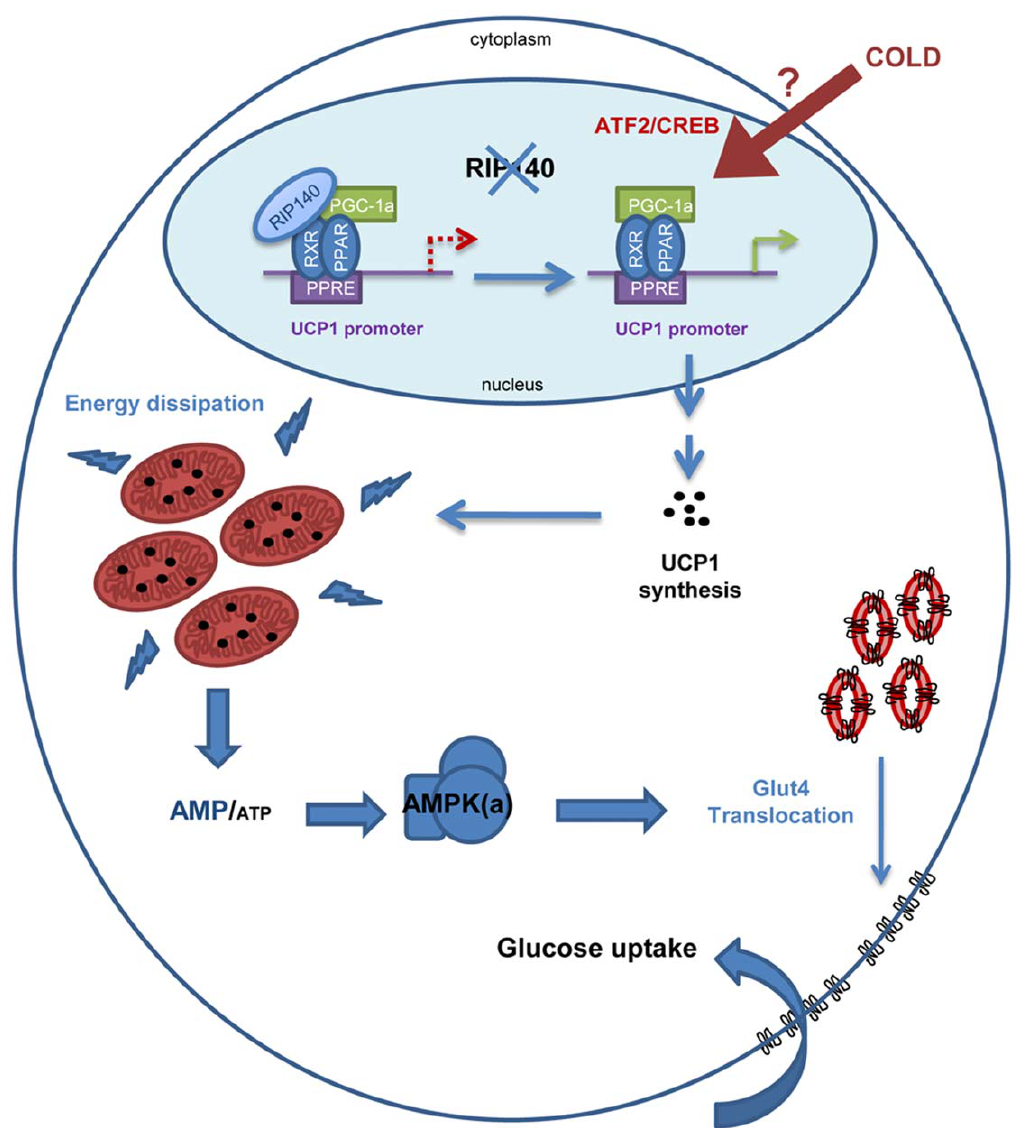
Figure 9. Schematic representation of the different steps leading to glucose uptake due to depletion of RIP140 in oxidative muscle. Absence of RIP140 leads to expression of UCP1 and mitochondrial uncoupling. Then, alteration of the AMP to ATP ratio in favor of elevated AMP activates AMPK which in turn stimulates GLUT4 translocation to the plasma membrane enabling the entry of glucose from blood circulation.